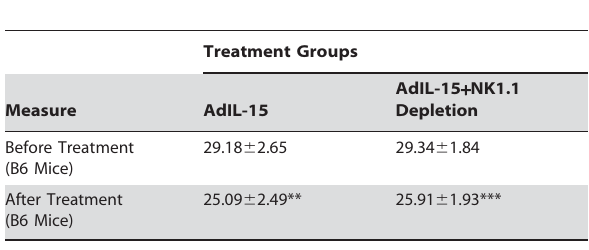
Table 2. Characteristics of mice before and after IL-15 treatment.